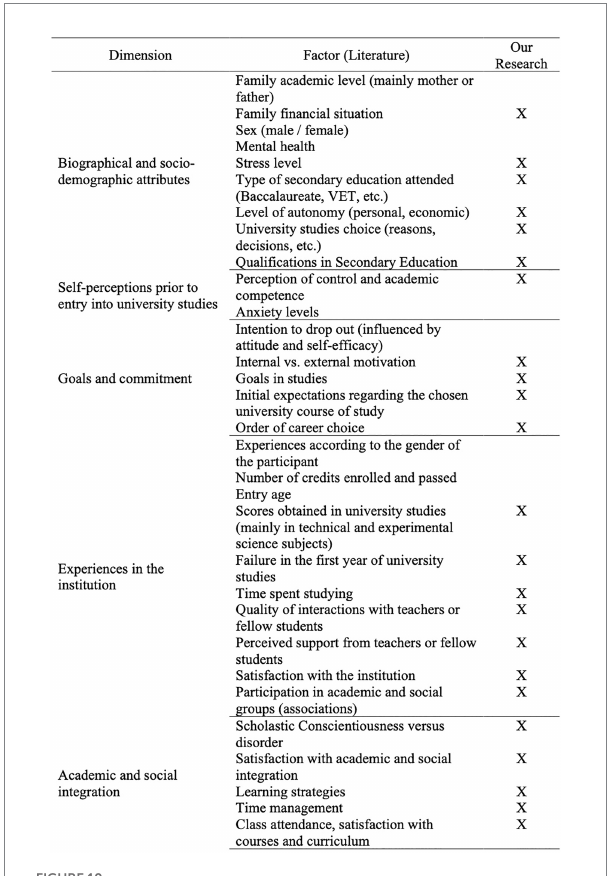
FIGURE 10 Factors related to early dropout and its dimensions (comparison of our results and those of the literature). Source. From Berlanga (2014), Lizarte (2020), Barroso et al. (2022), and Lizarte Simón and Gijón Puerta